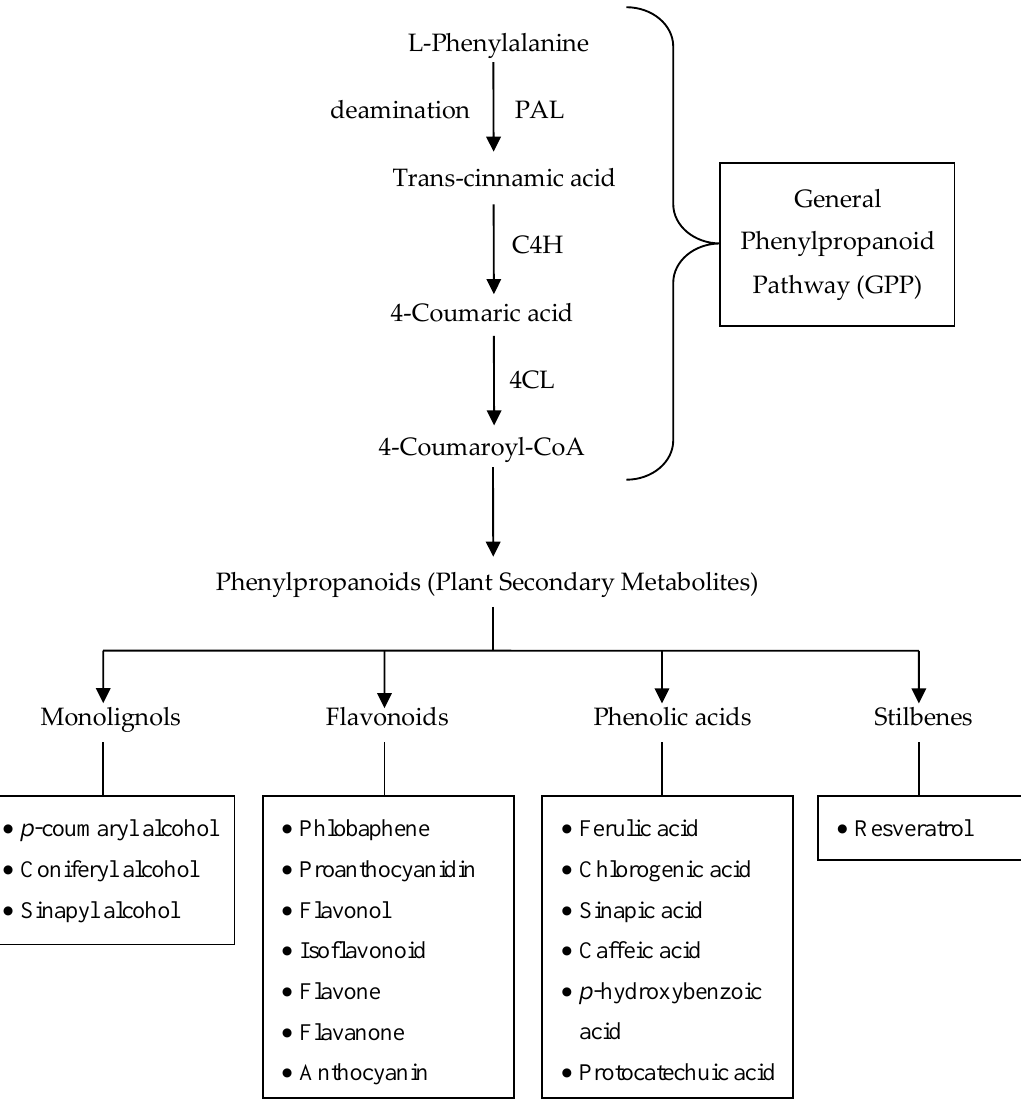
Figure 9. Biosynthesis pathway of some plant phenylpropanoid compounds (PAL = phenylalanine ammonia lyase; C4H = cinnamate 4-hydroxylase; 4CL = p -coumaroyl coenzyme A ligase). Adapted from: [101,102].